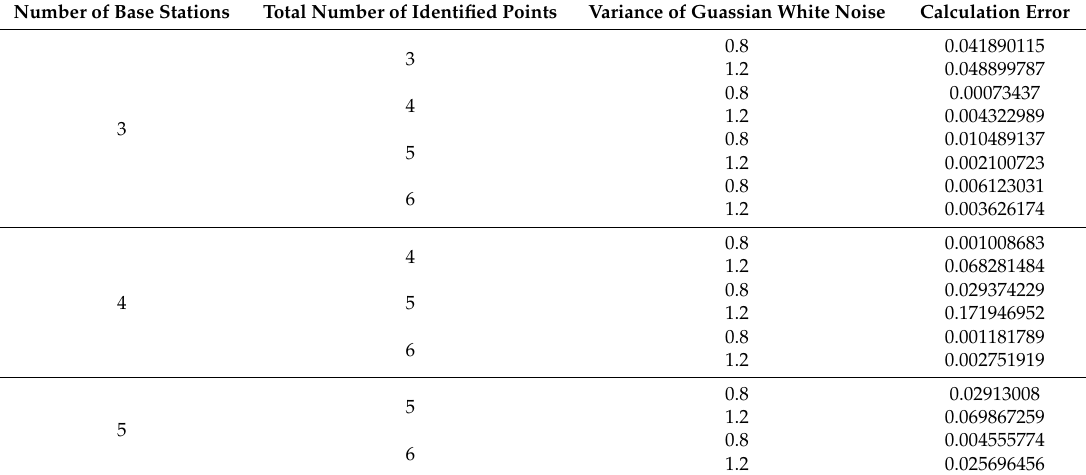
Table 4. The result of simulation experiment of multi-base stations.